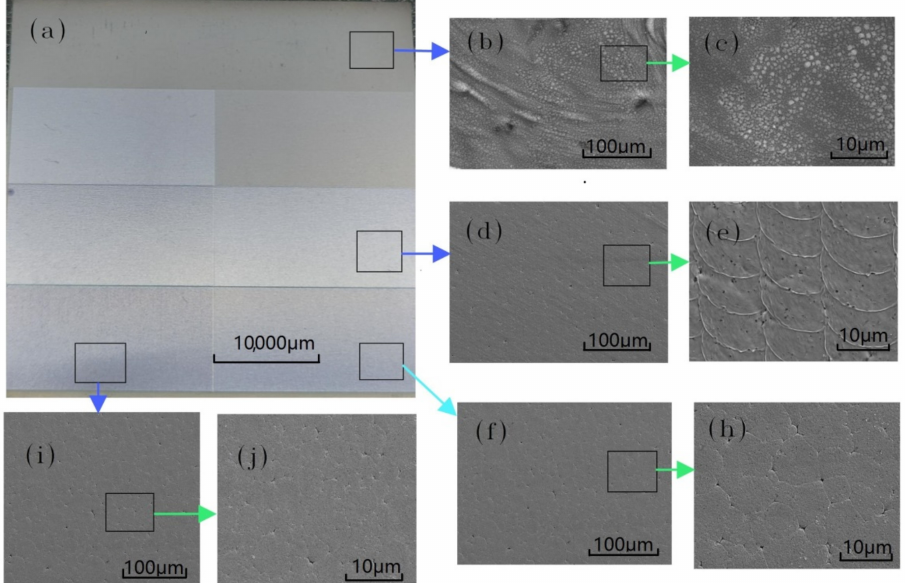
Figure 11. SEM images of SiC substrate after laser cleaning with difference conditions. ( a ) Photo of silicon carbide after laser cleaning, ( b ) SEM images of the original surface, ( c ) Magnification SEM images of the original surface, ( d ) SEM images of the laser cleaning with laser power 5 W, ( e ) Magnification SEM images of the laser cleaning with 5 W, ( f ) SEM images of the laser cleaning under 25 W, ( h ) Magnification SEM images of the laser cleaning under 25 W, ( i ) SEM images of the laser cleaning at 25 W and with airflow, and ( j ) Magnification SEM images of the laser cleaning under 25 W and with airflow.